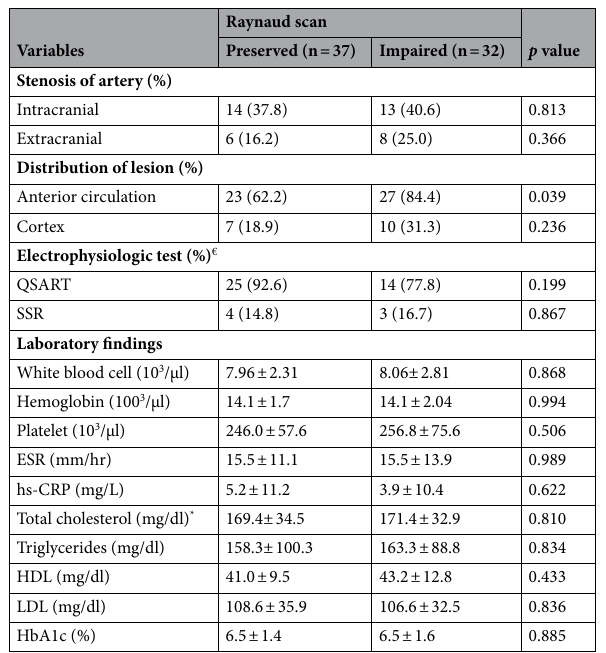
Table 2. Diagnostic features of study population. QSART Quantitative sudomotor axon reflex test, SSR sympathetic skin response, ESR erythrocyte sedimentation rate, hs-CRP high sensitivity C-reactive protein, HDL high density lipoprotein, LDL low density lipoprotein, HbA1c hemoglobin A1c. * Lipid profile (Preserved 36, Impaired 30). € Preserved 27, Impaired